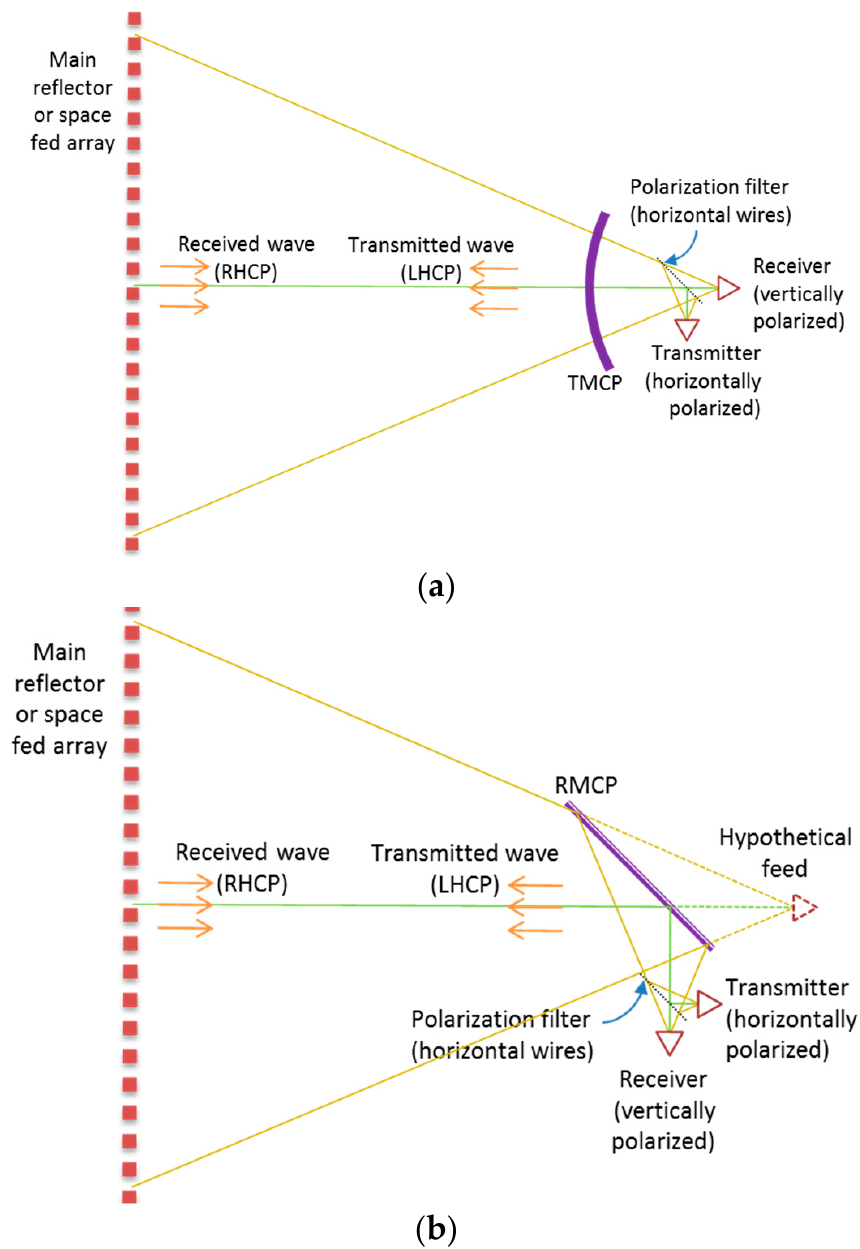
Figure 3. Schematics of reflectors, lenses or space fed arrays for right-handed circularly polarized (RHCP) receiving and left-handed circularly polarized (LHCP) transmitting waves by use of ( a ) the transmission-mode linear to circular polarization converter (TMCP) and ( b ) the reflection-mode linear to circular polarization converter (RMCP).